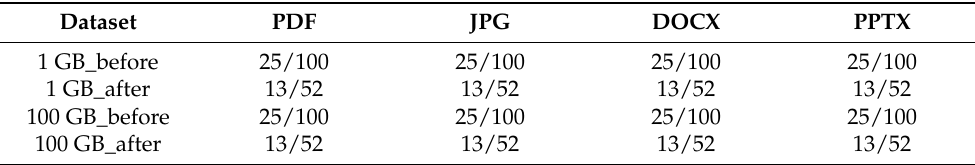
Table 3. Number of files/total number of files by file type that exist within the dataset used in the experiment.